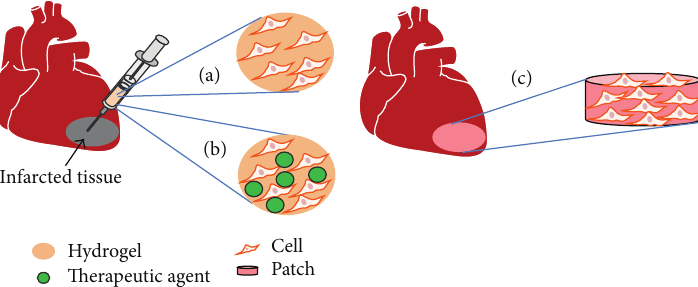
Figure 1: Strategies to improve cell retention in infarcted hearts. An injectable hydrogel can be used as a delivery vehicle for cells (a), or cells and therapeutic agents such as genes or proteins (b). A scaffold can be seeded with cells in vitro and then implanted to the infarcted region